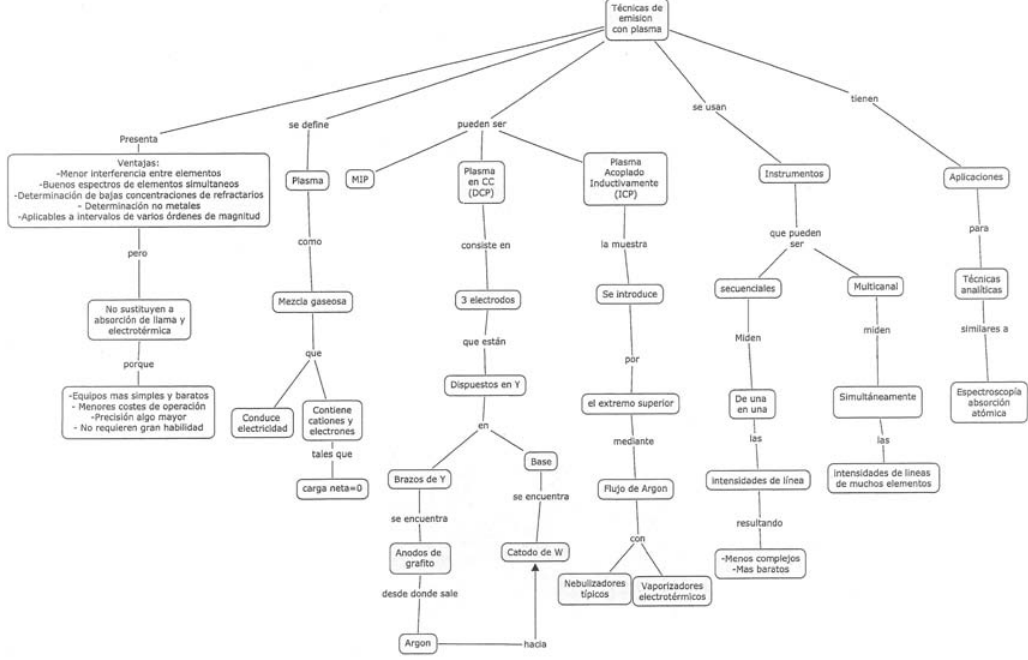
Figure 3. “Example of concept map elaborated by the students in the subject Analytical Techniques of the